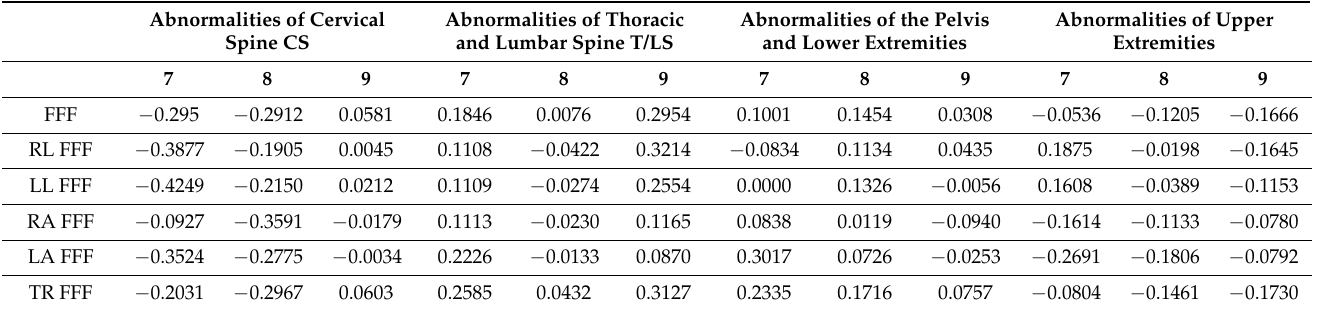
Table 5. Correlation between the FFF index and the incidence of body posture abnormalities in individual age